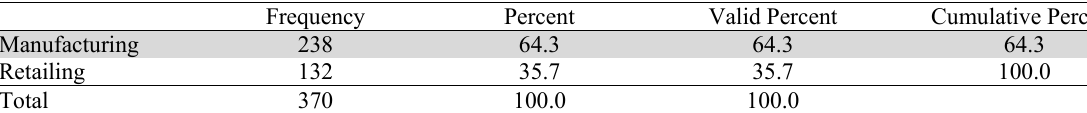
The classification of sectors